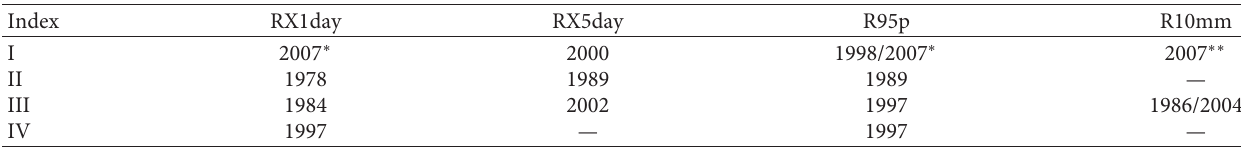
∗ , ∗∗ Values show statistically significant trend at the 0.05 and 0.01